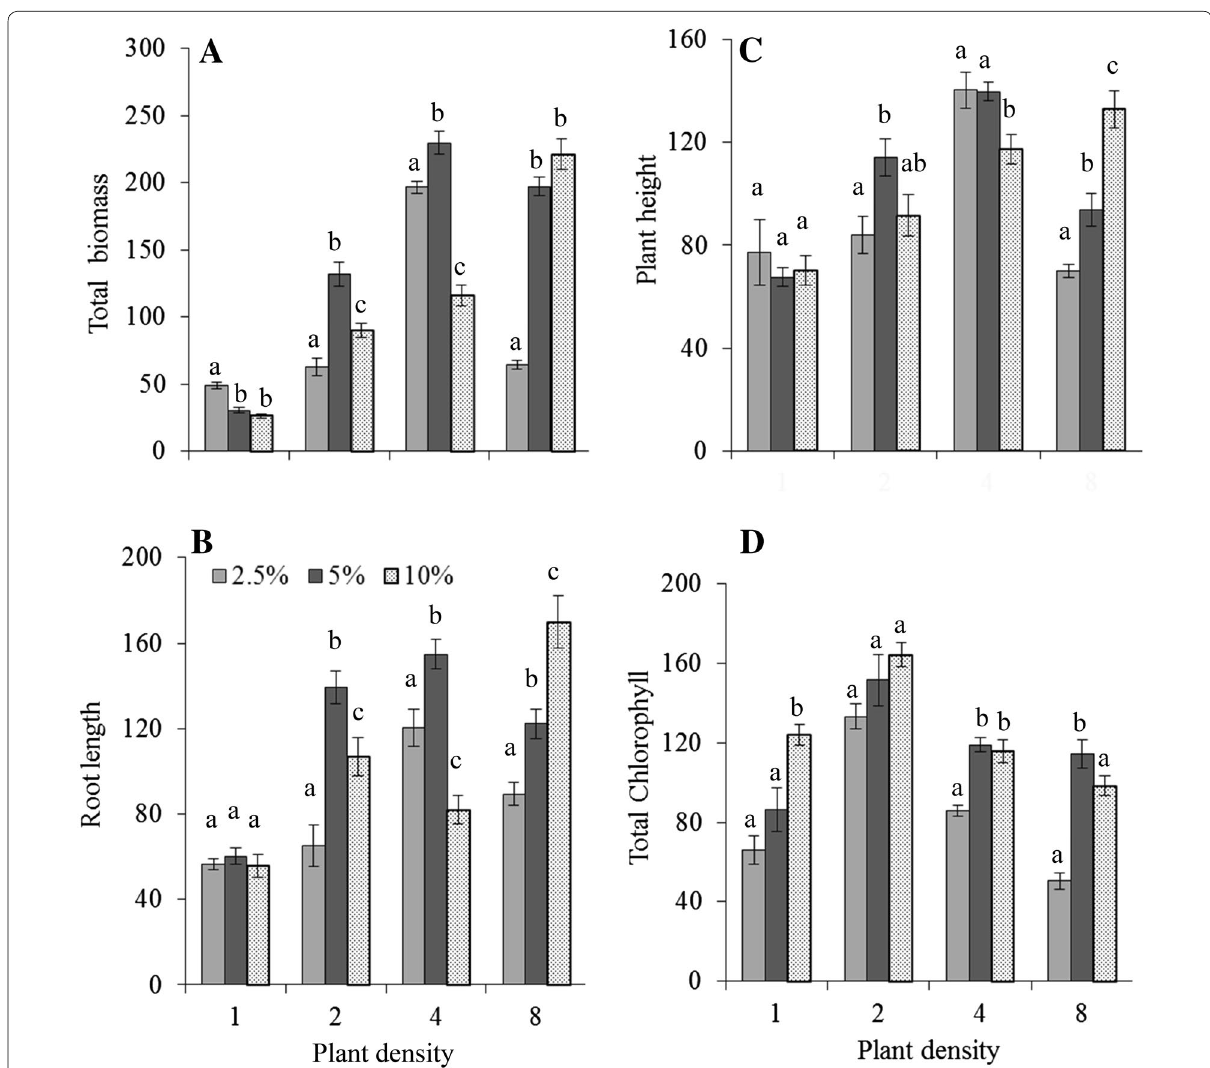
Fig. 1 Effects of Phragmites australis litter leachate on A total biomass, B root length, C plant height and D total chlorophyll of Rumex conglomeratus seedlings at different densities. Values (weight per plant) are means as % of control treatments at each density indicate homogenous subgroups ( P 0.05) at each density in Duncan’s ≤